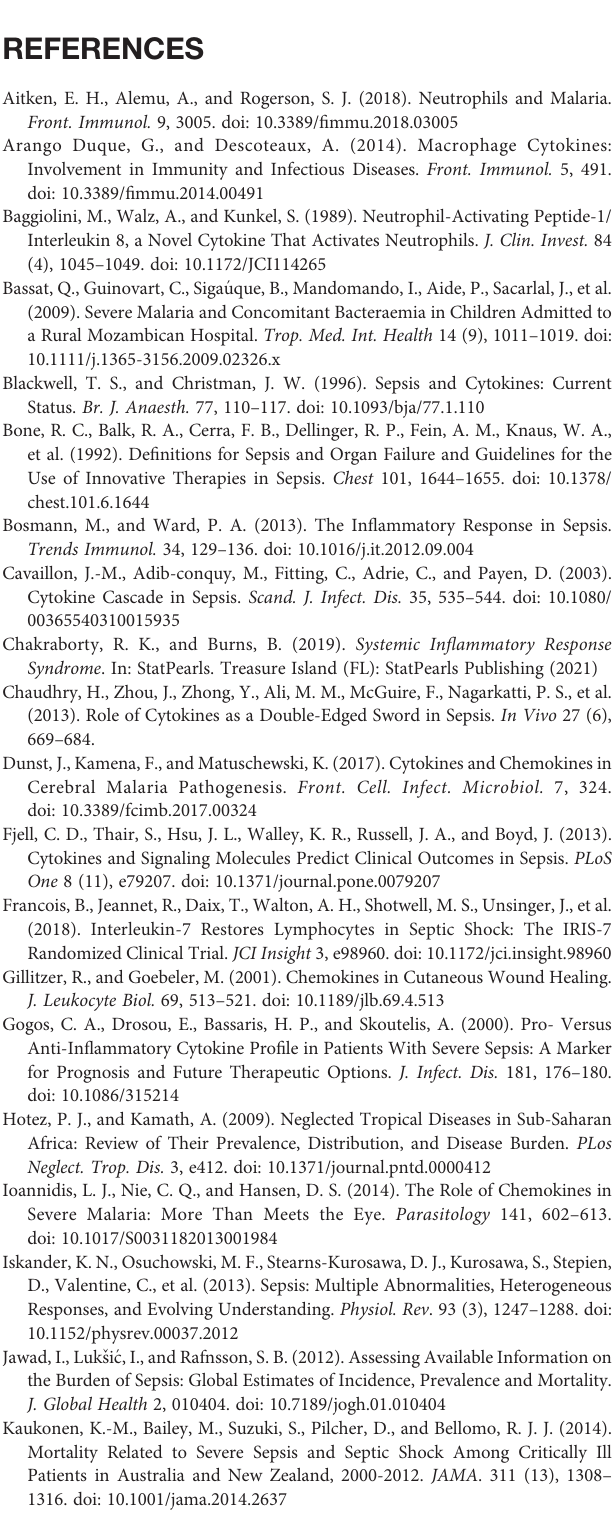
children with sepsis and clinical malaria. The plots indicate the median and interquartile ranges. Signi fi cant differences were considered when p<0.05. Statistically signi fi cant values are denoted as ****p < 0.0001. Statistical analyses were performed using the Mann Whitney U